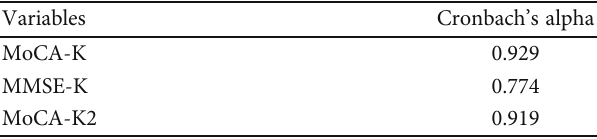
Table 3: Reliability of the three clinical tools ( N = 185